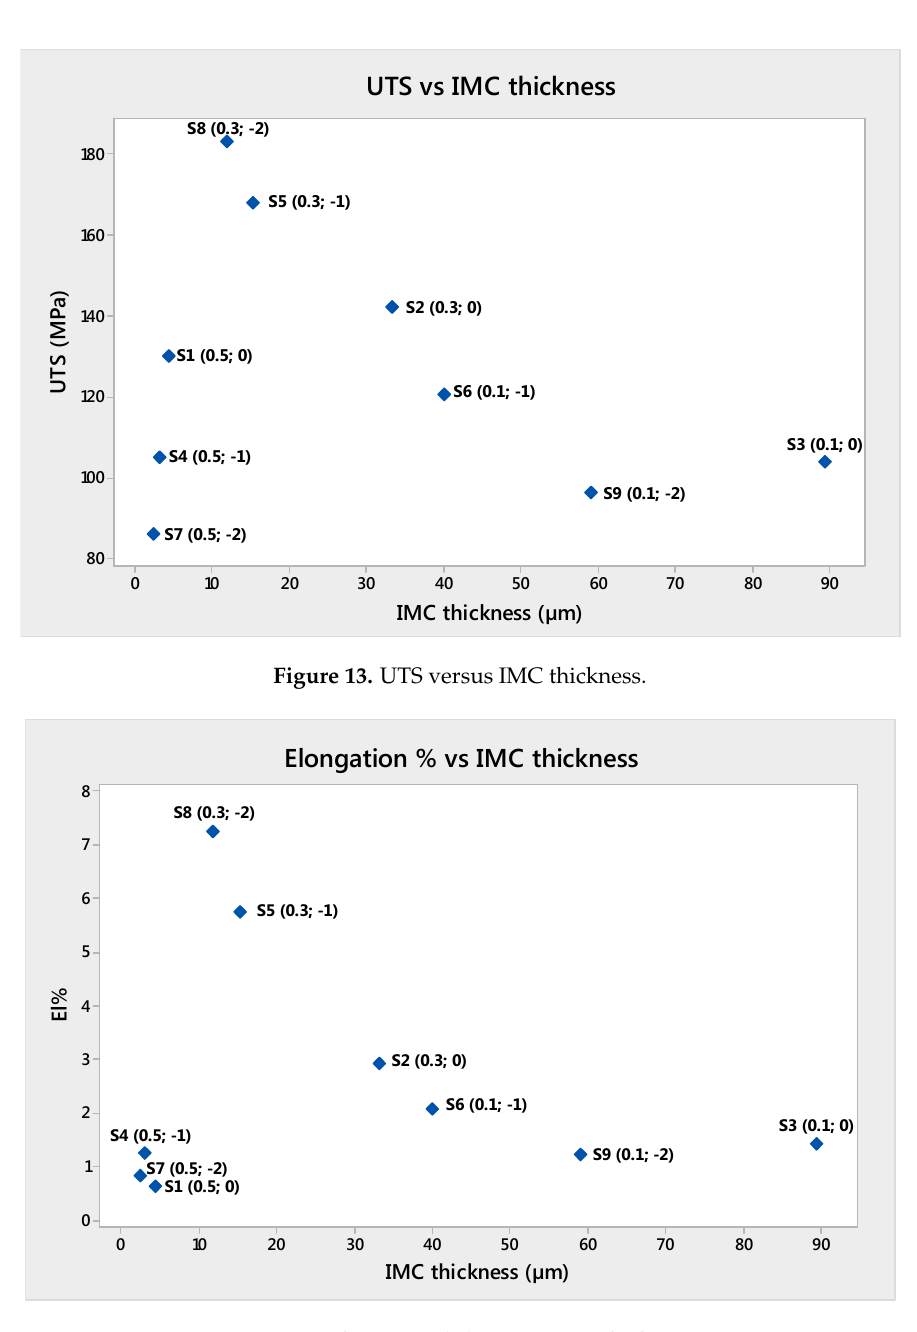
Figure 14. Elongation (%) versus IMC thickness.